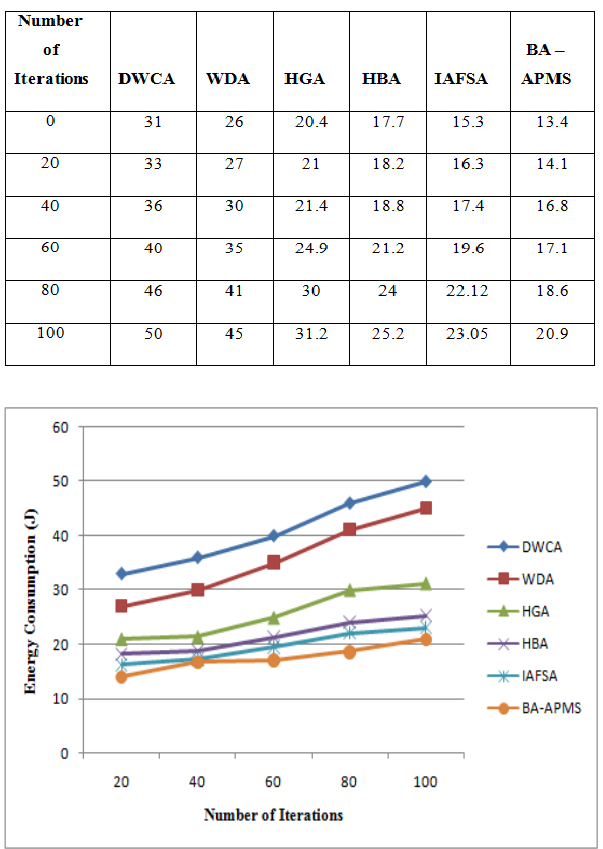
Table 4. Energy Consumption Comparison